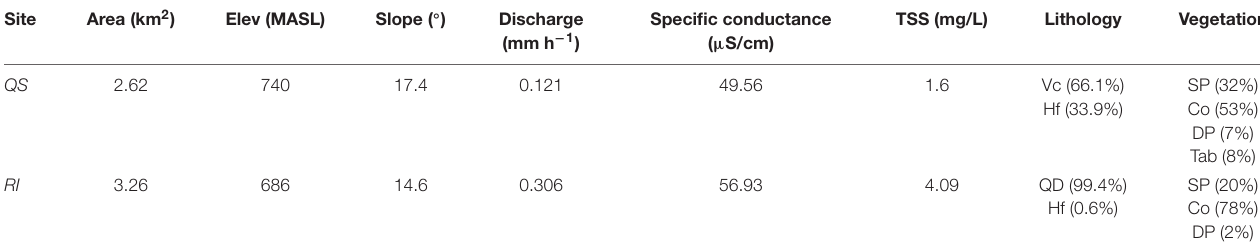
TABLE 1 | Watershed characteristics and background hydrologic and stream chemistry metrics for Quebrada Sonadora (QS) and Rio Icacos (RI).